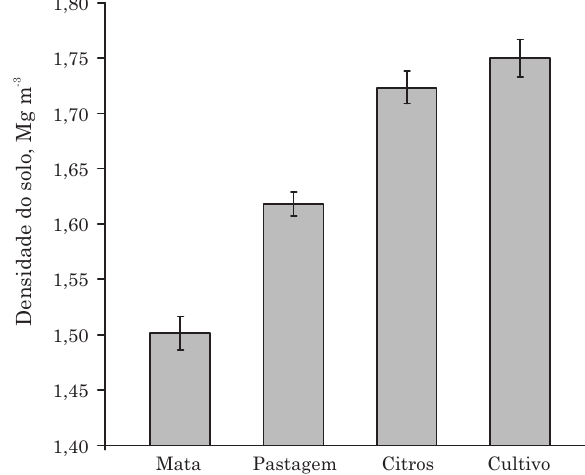
Figura 1. Valores médios de densidade do solo para cada tratamento e intervalo de confiança, indicados pelas barras verticais. Quando os limites superior e, ou, inferior do intervalo de confiança se sobrepõem não há diferença estatisticamente significativa entre os tratamentos